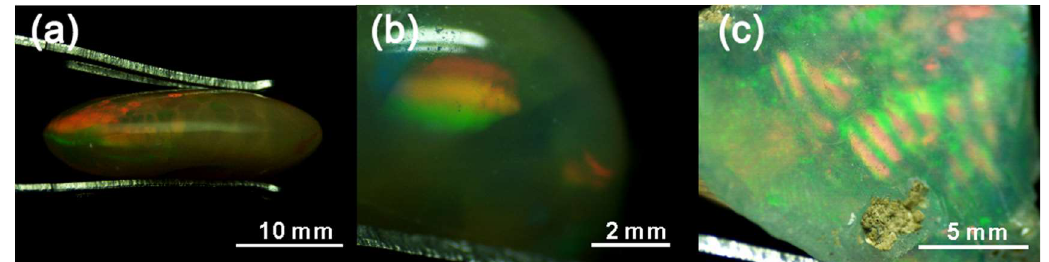
Figure 7. Spectral colour in Ethiopian opals. ( a ) Pure spectral colour (Opal-01); ( b ) Pure spectral colour (Opal-06); ( c ) Gradient spectral colour (Opal-07).